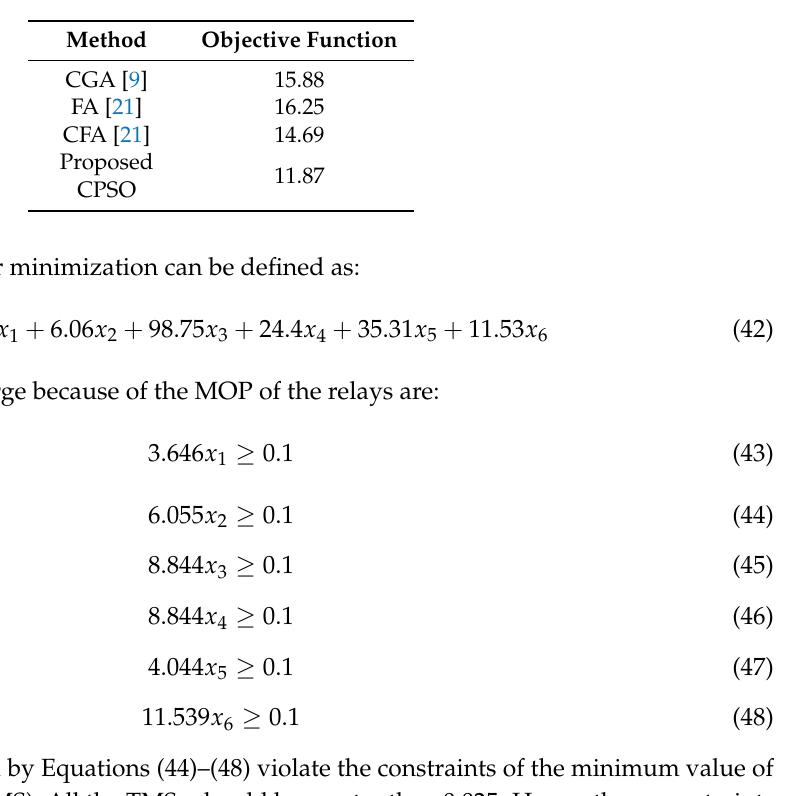
Table 18. Comparison of the proposed method results with the literature for Case